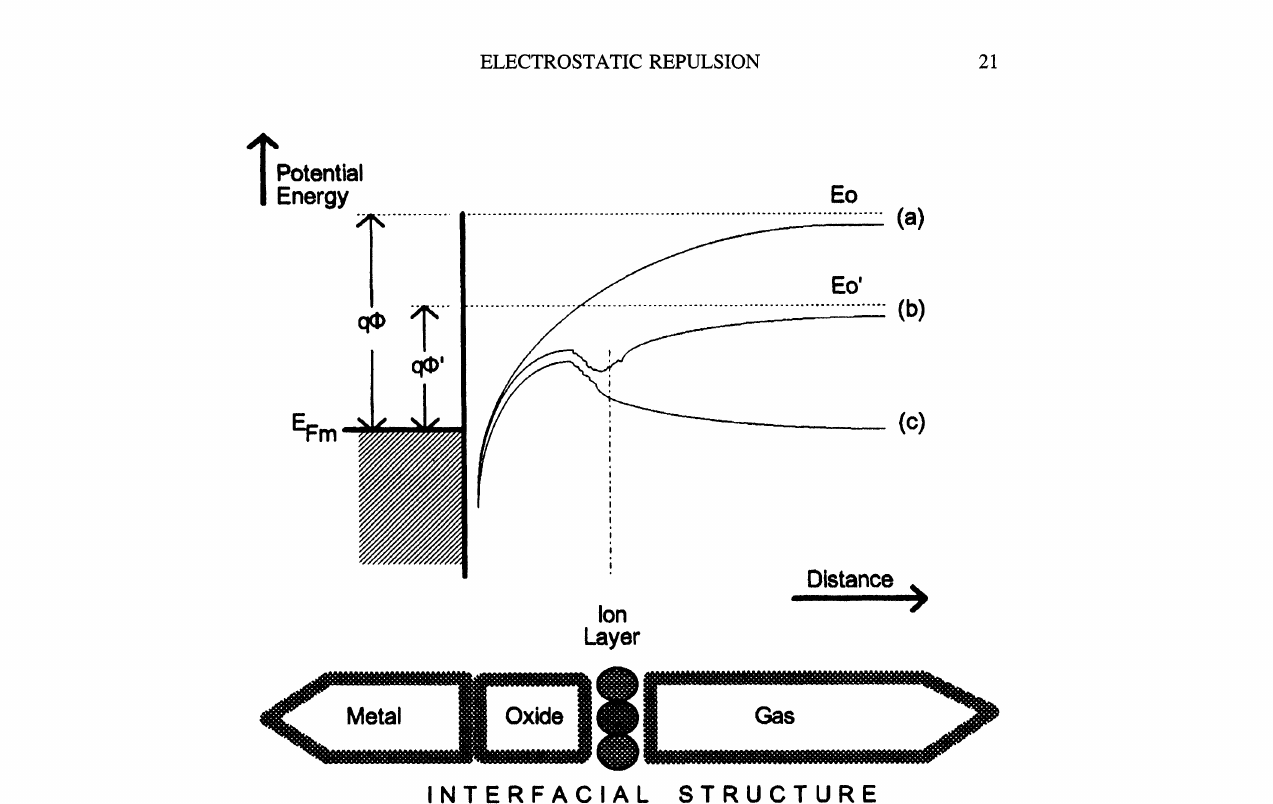
Dependence of the effective work function, #, on the metal surface condition. (a) Ideal metal-vacuum interface. (Eo is the vacuum level). (b) Metal-oxide-ion layer-vacuum structure. (Eo’ is the corresponding vacuum level). (c) Same structure as in case (b) having externally applied potential. (The metal electrode is positive). The constituent layers of the interfacial structure are indicated underneath. The arrows in the gas and metal layers imply that these materials extend significantly towards these